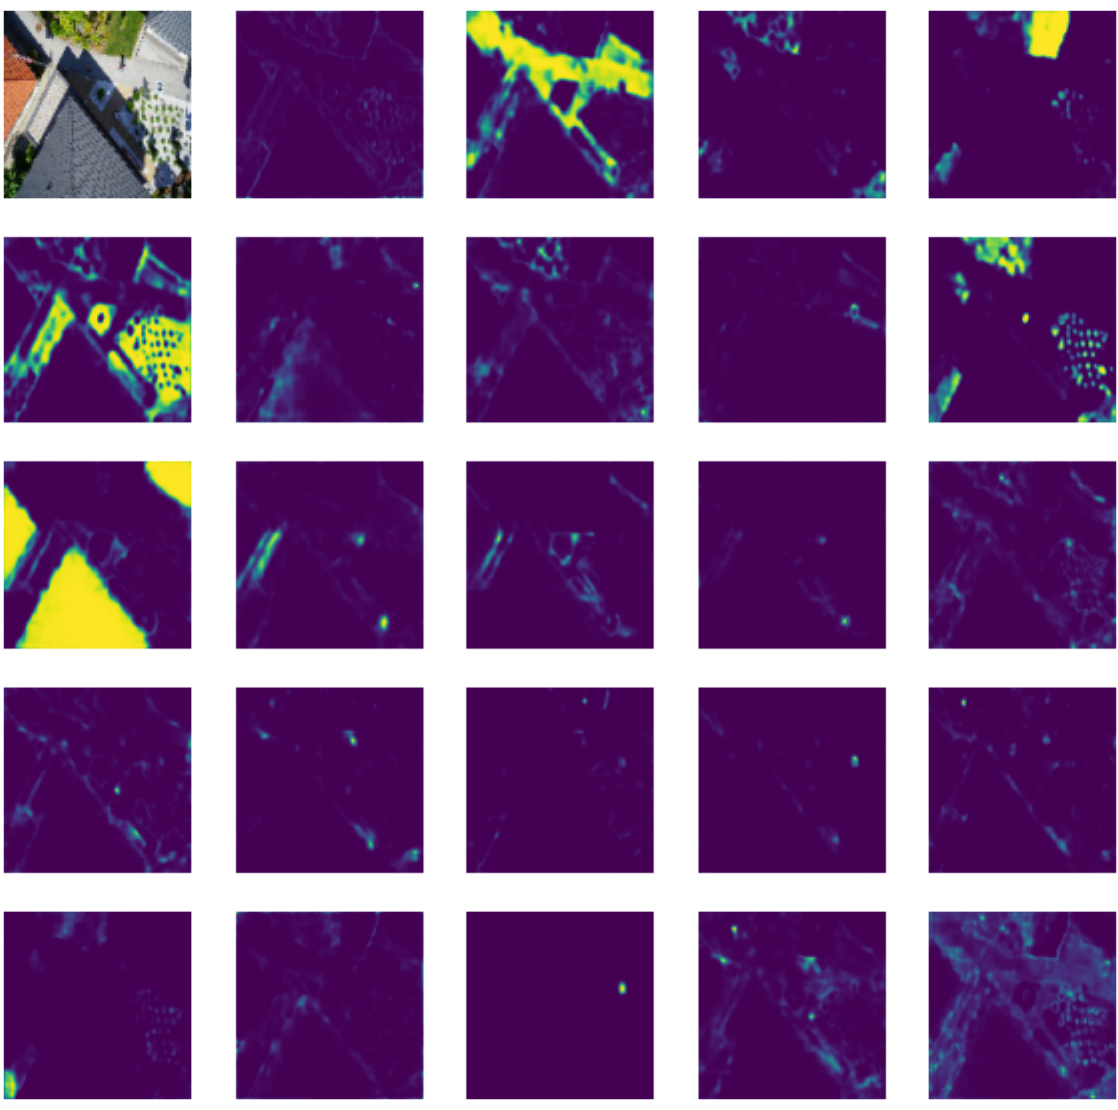
Figure 5. Predicted feature maps from the backbone CNN architecture; these feature maps are pooled at various sizes and later transferred within convolution